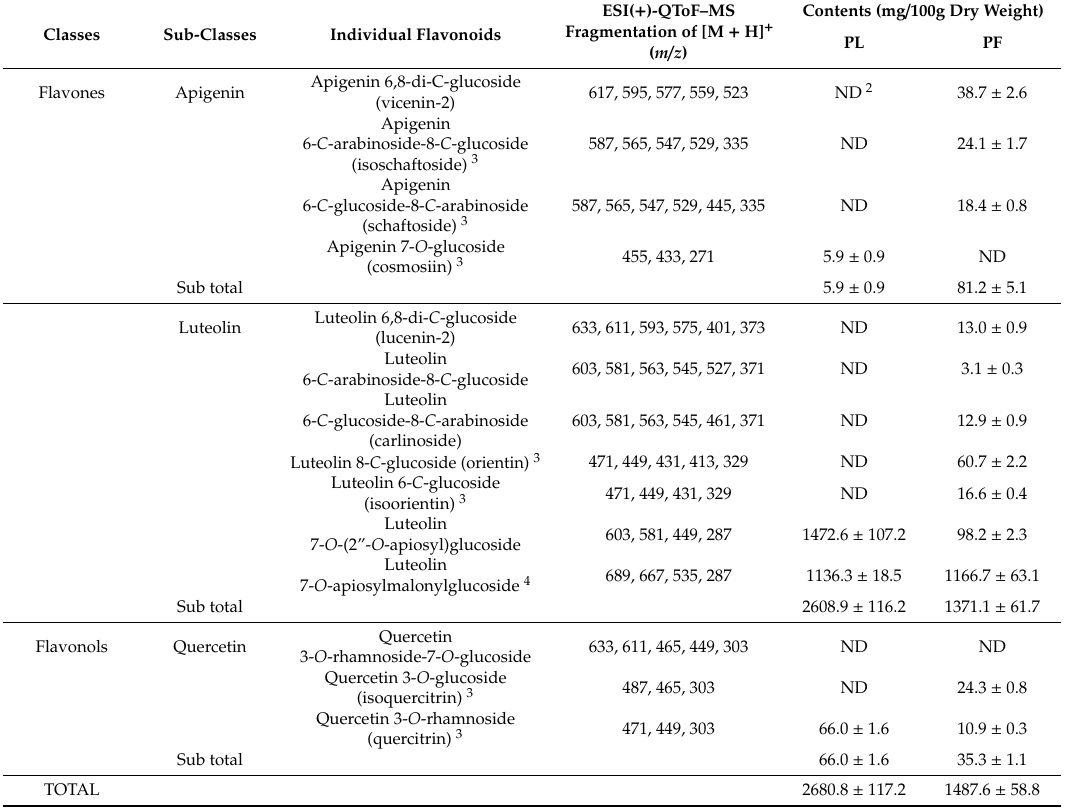
Table 2. Characterization of individual flavonoids in pepper leaves (PL) and pepper fruits (PF) 1 .